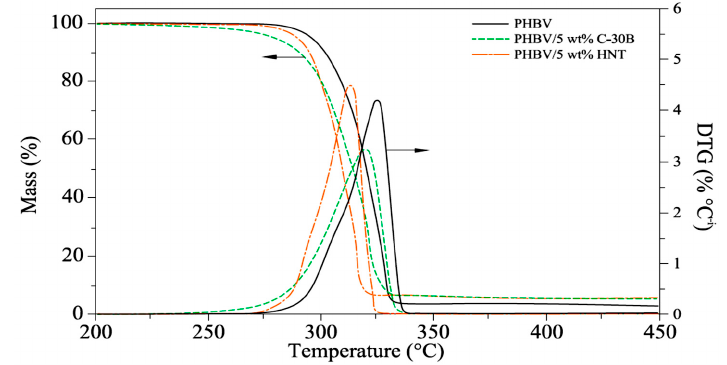
Figure 12. TGA and DTG curves of PHBV nanocomposites with 5 wt % nanoparticles [74].